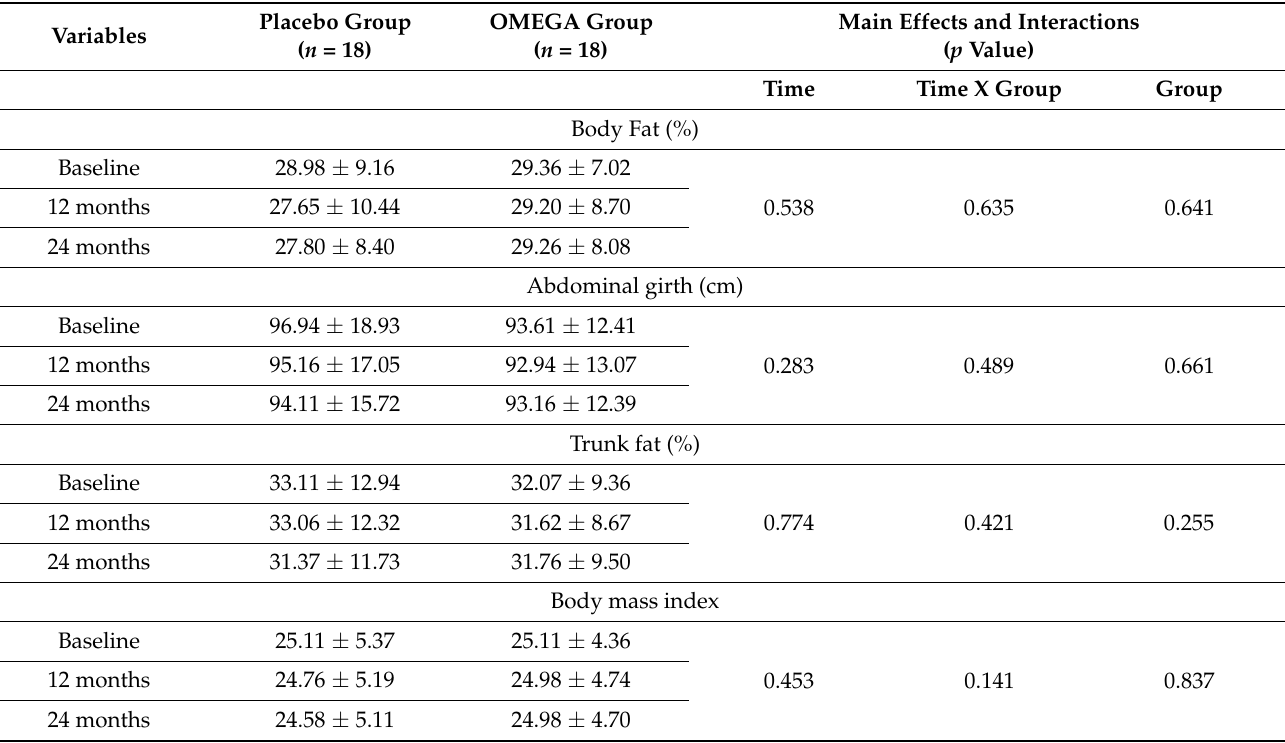
Table 5. Body composition, abdominal girth and trunk fat in both groups for all three time-points excluding the dropouts.